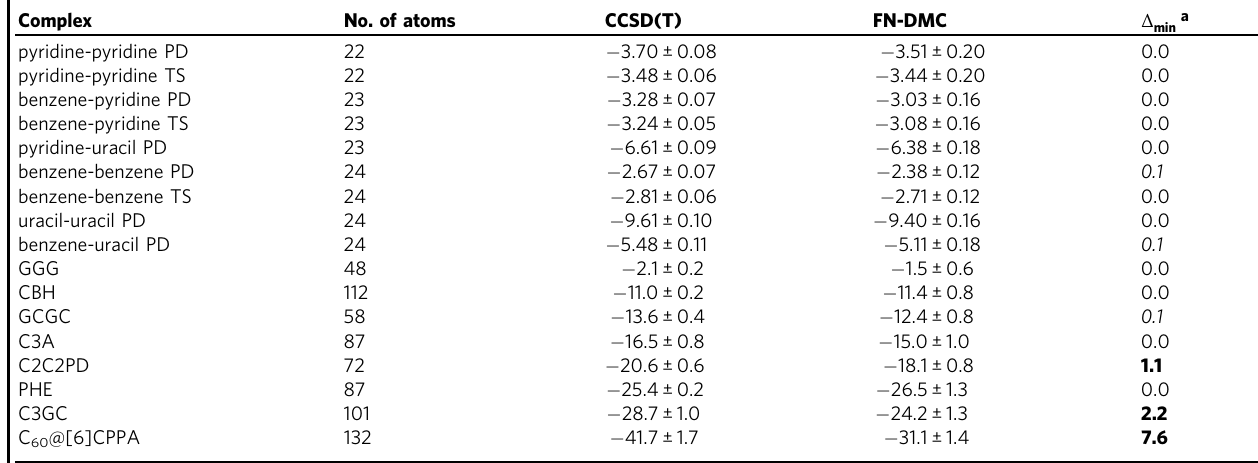
Table 1 Interaction energies in kcal mol − 1 for best estimated CCSD(T) and FN-DMC, as well as their minimum differences ( Δ for dimers taken form the S66 compilaton, for the L7 supramolecular data set and the buckyball-ring complex (C 60 @[6]CPPA). The indicated errors for CCSD(T) are extrapolated from the convergence of basis sets and local approximations in LNO-CCSD (T). The errors indicated in FN-DMC interaction energies account for the stochastic uncertainty of the estimation, and identi fi es a 95% con fi dence interval (i.e., ± 2 σ